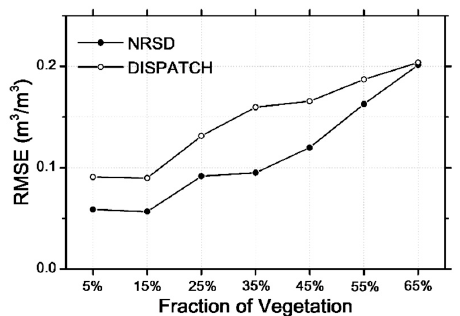
Figure 9. Error analysis by running NRSD and DISPATCH in various densities of vegetation condition. Five percent represents that all disaggregated soil moistures with vegetation fraction from zero to 10% were considered, and the rest can be done in the same manner.